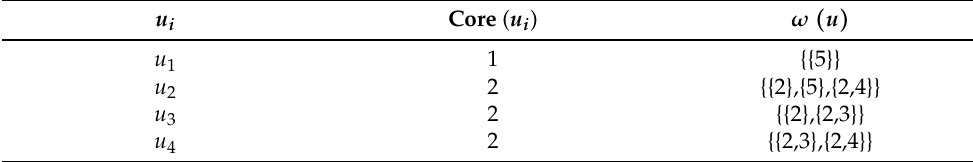
Table 1. Core number and vertex signatures for the multigraph in Figure